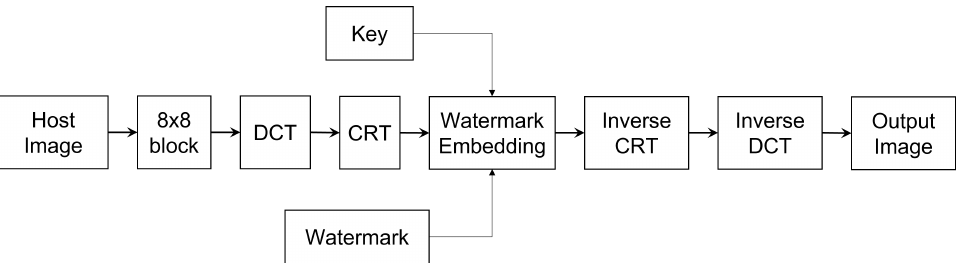
Figure 6. Overview of watermark embedding process.